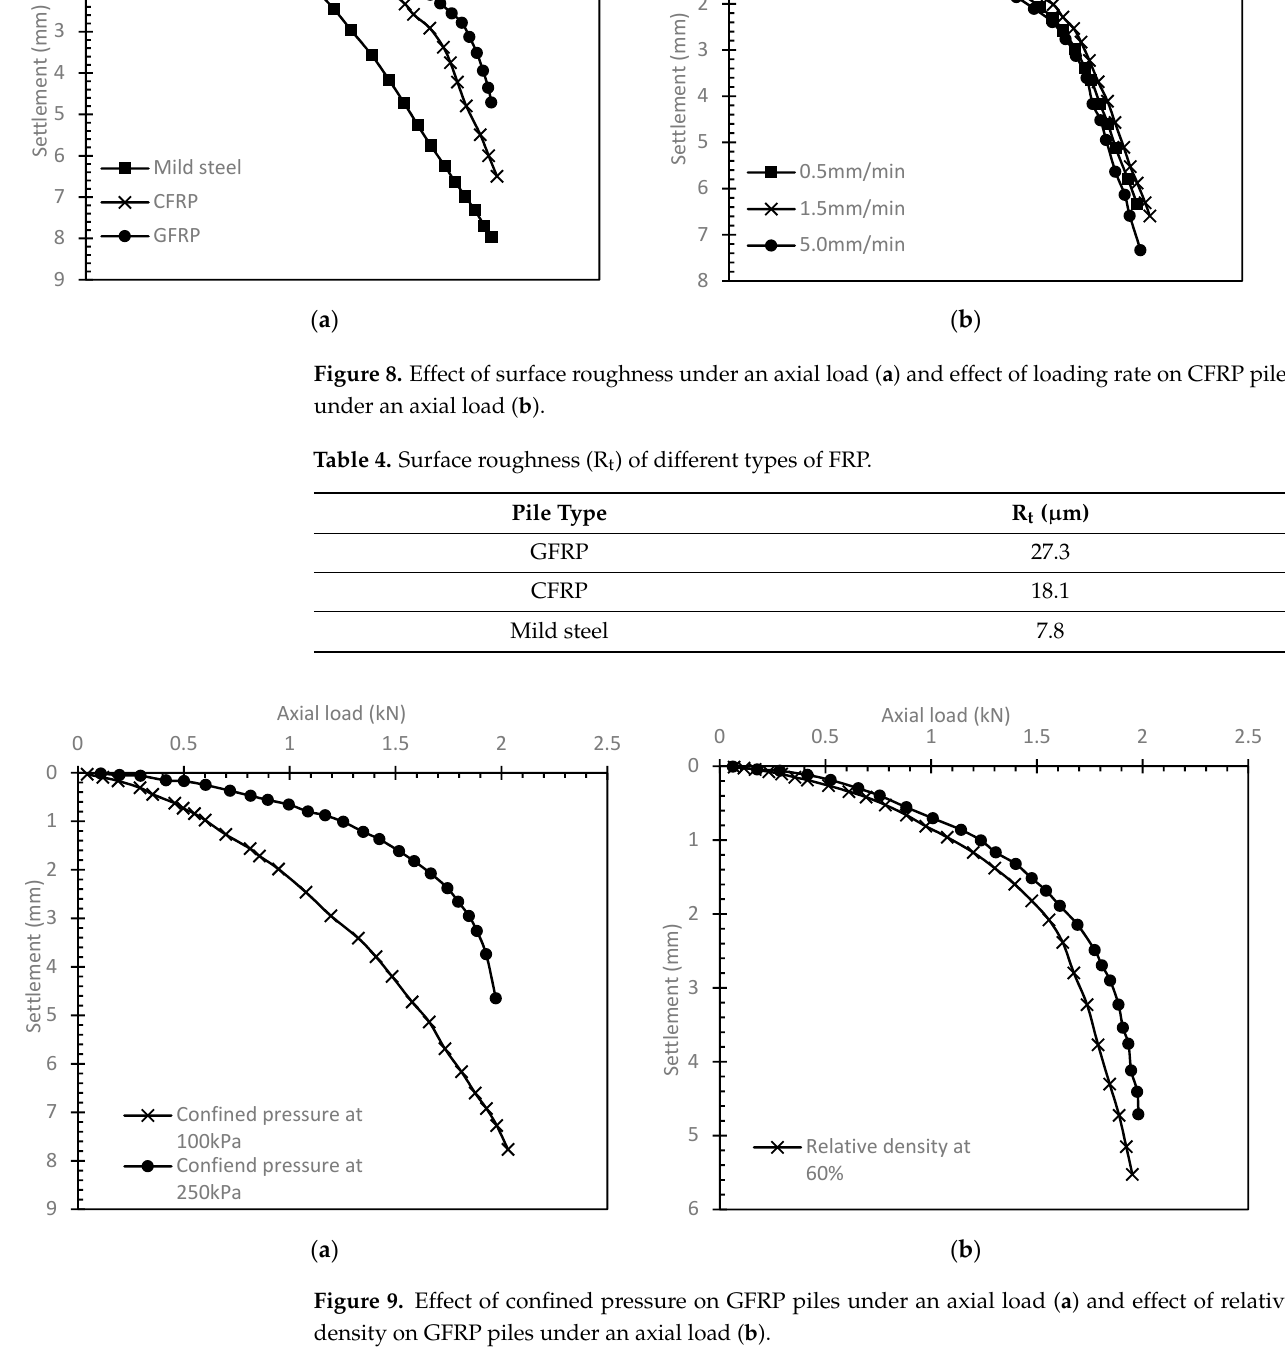
Table 4. Surface roughness (R t ) of different types of FRP.